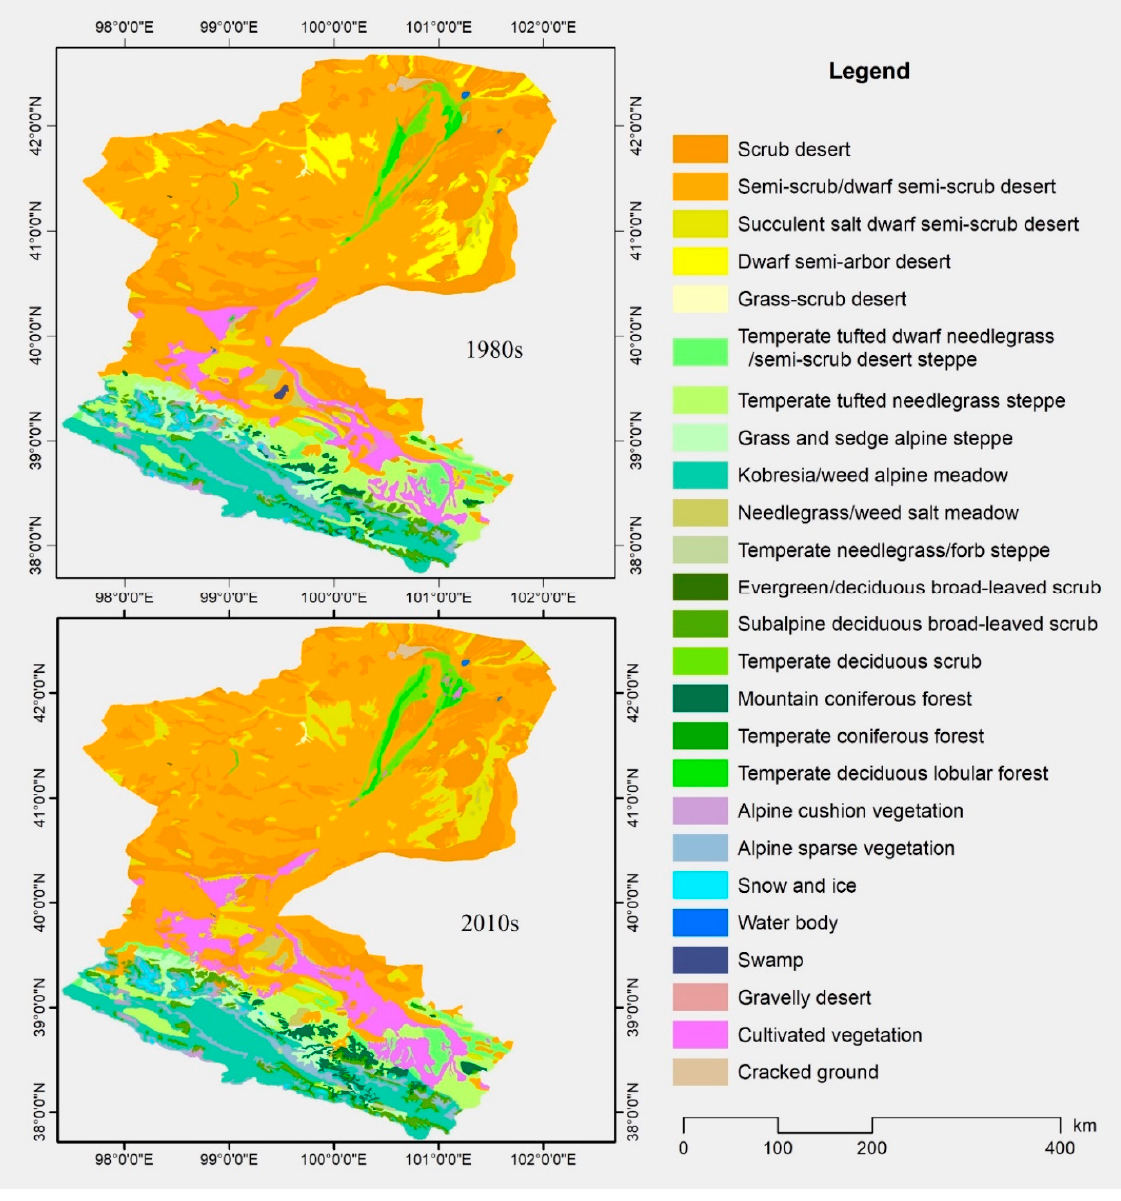
Figure 2. Spatial distribution of vegetation in Heihe River Basin in the 1980s and 2010s.